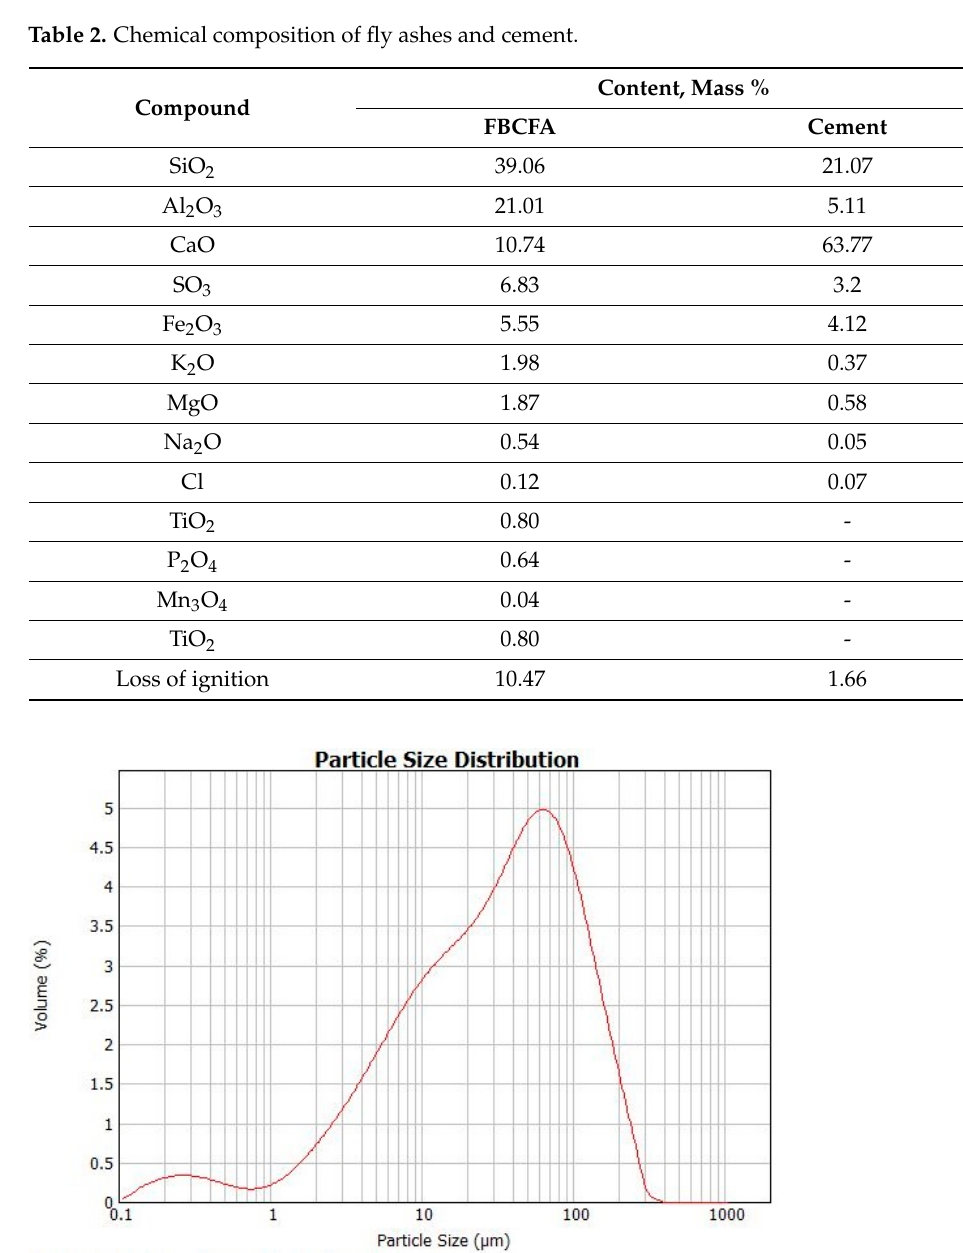
Table 1. Grain size distribution curves of the sand and gravel .